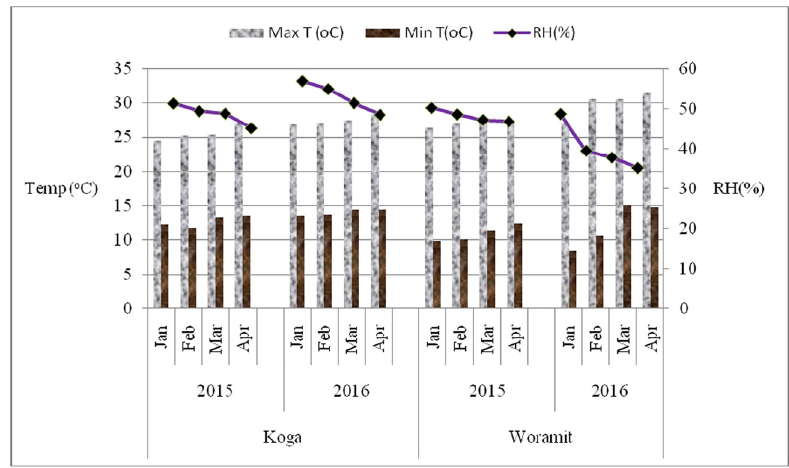
Figure 1: Environmental condition maximum and minimum temperature ( o C ) and relative humidity RH ( % ) of the study areas during the experimentation